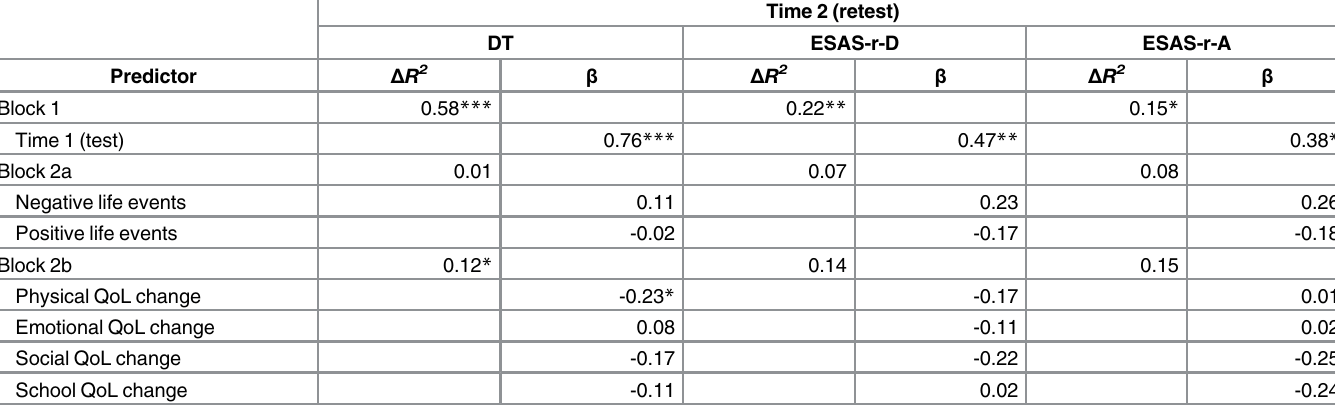
Table 4. Summary of Hierarchical Regressions Predicting Instability of Test